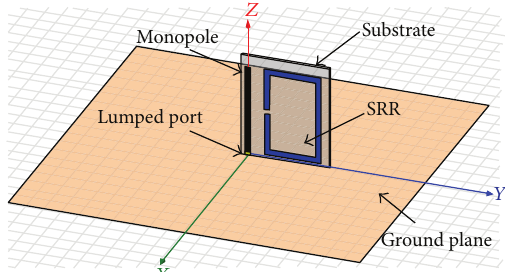
Figure 1: HFSS model for the antenna with configuration A1.